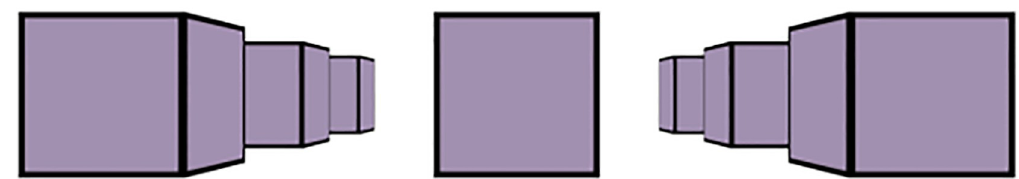
Fig 6. Effect of separation mismatches from the cyclopean eye (i.e., only monocular depth cues). The brown cubes are the simulations in the original world and the blue cubes are the simulations in the reconstructed world. They are identical from the view of cyclopean eye.